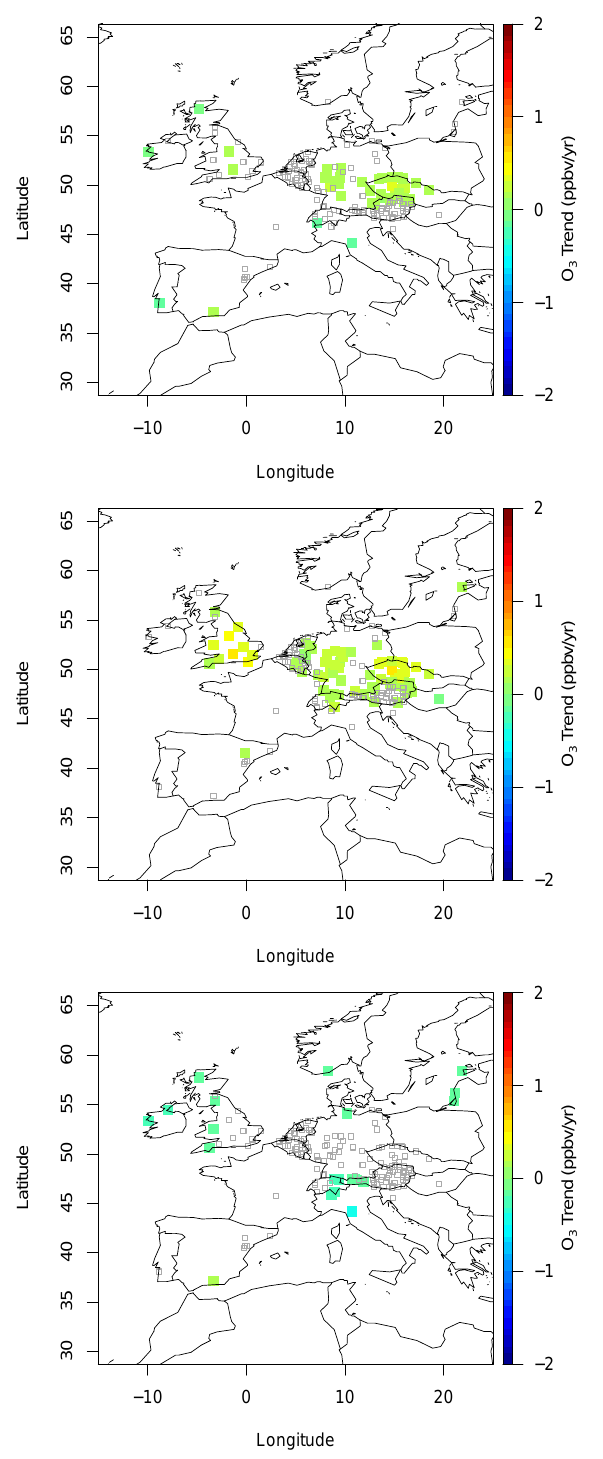
Fig. 12. Spatial distribution of significant (p < 0.1) annual CHIMERE modelled trends (ppbv/yr) in O 3 mean (top), 5th (middle) and 95th percentiles (bottom) 1996–2005. Open squares=sites with no statistically significant trends.